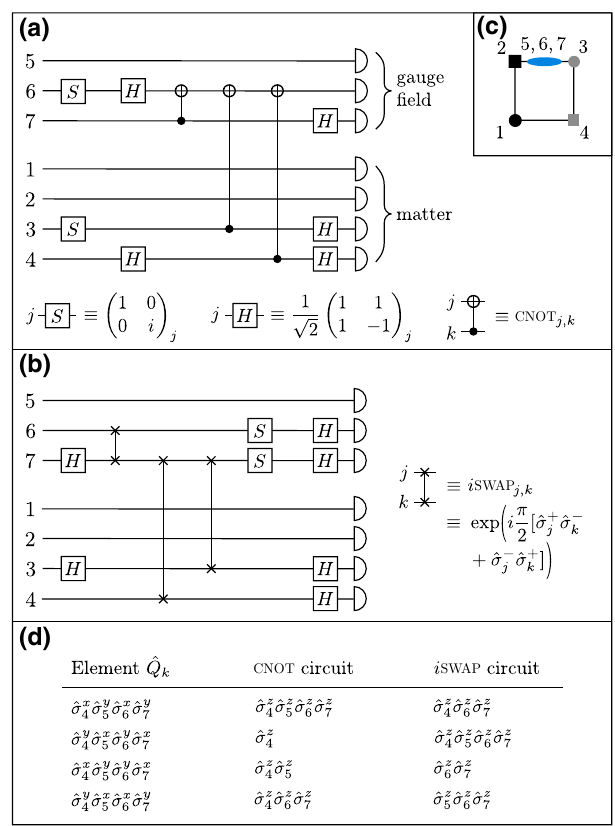
FIG. 11. An example of the measurement protocol explained in the main text and Appendix B, applied to the open-boundary plaquette (see Sec. II B). The circuits shown diagonalize a mea- surement set ˆ R m using controlled- NOT ( CNOT ) gates (a) and i SWAP gates (b) as an entangling operation. The qubit labeling conven- tions are shown in (c). Applying the circuits before performing local measurements in a VQE protocol amounts to effectively performing measurements in an entangled basis. The table in (d) ˆ lists the elements Q k in the chosen measurement set and their corresponding diagonalized elements using the CNOT circuit and the i SWAP